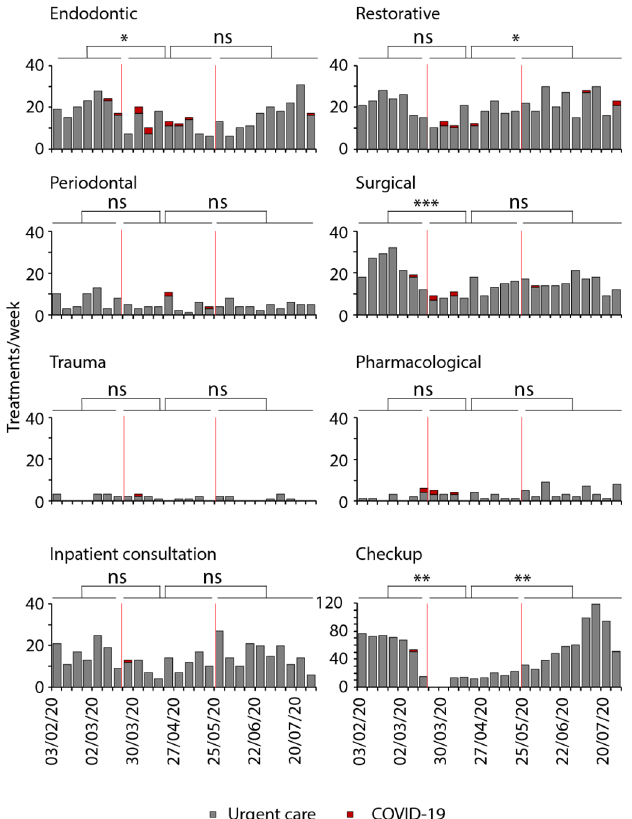
Figure 4. Dental treatments carried out in the urgent dental care unit during the initial period of the COVID-19 pandemic. Treatments performed on patients per week in the urgent dental care unit from 3 February to 31 July 2020. Treatments were categorized into endodontic (n = 410), restorative (n = 525), periodontal (n = 137), surgical (n = 410), trauma (n = 32), and pharmacological (n = 77) interventions as well as inpatient consultations (n = 370) or checkups with minor questions (n = 1160). The first red line marks the beginning and the second marks the end of the national lockdown, dividing the time into pre-lockdown, lockdown, and post-lockdown. The red bars represent patients with high risk of or confirmed COVID-19 infection (ANOVA or Kruskal–Wallis; * p ≤ 0.05, ** p ≤ 0.01, *** p ≤